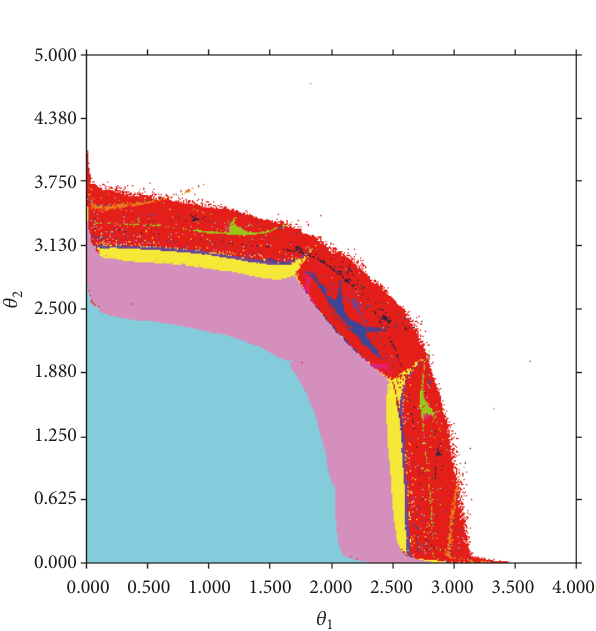
Figure 3: The parameter basin plots of system (14).